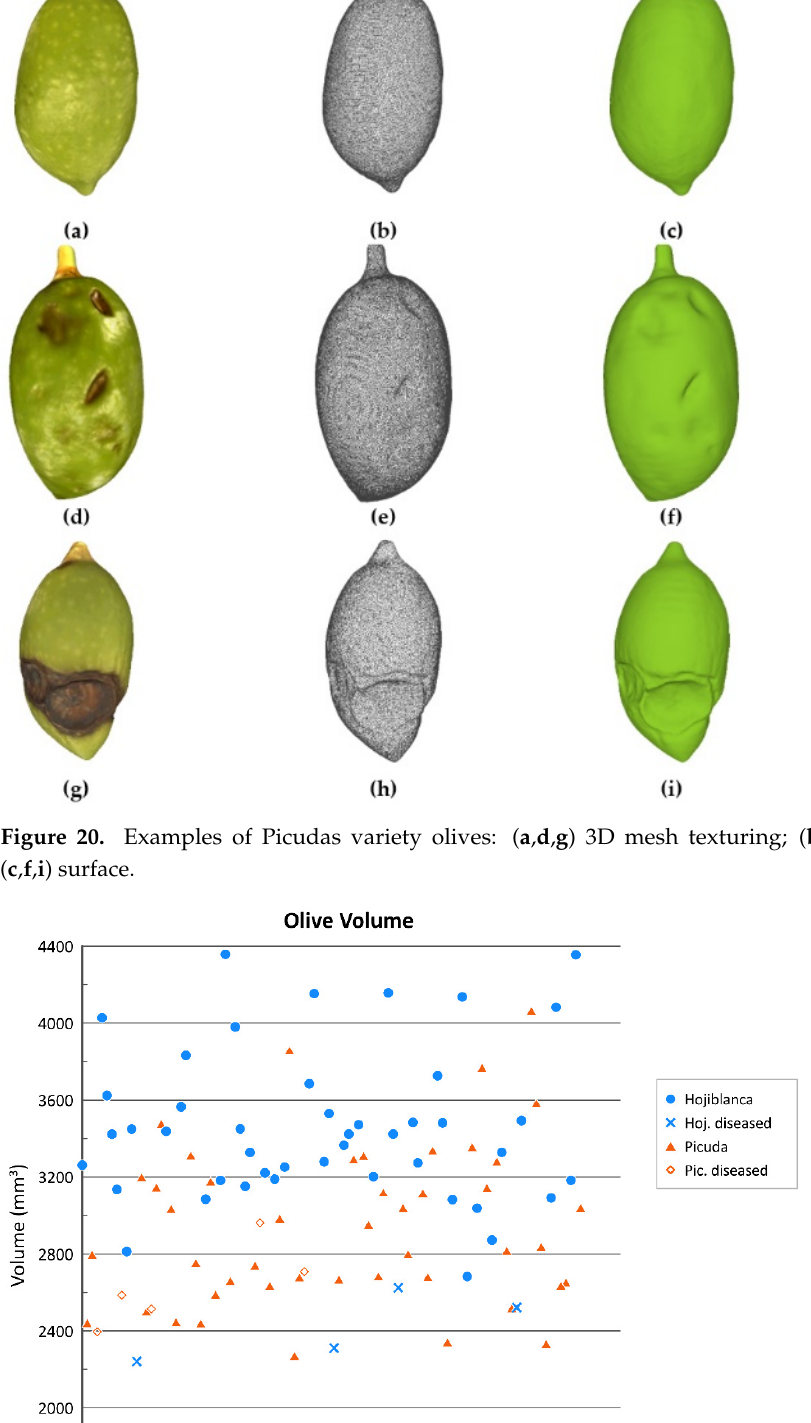
Figure 21. Total Volume plot. The surfaces of the olives are represented in Figure 22.